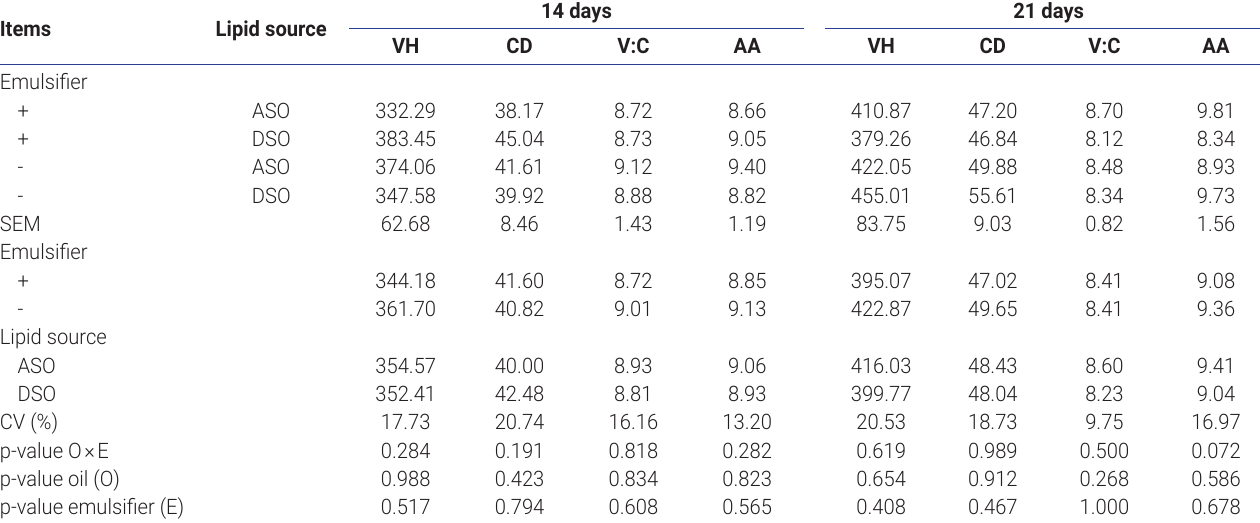
Table 8. Villus height, crypt depth, villus:crypt ratio, and area of absorption of jejunum of broilers fed diets containing different lipid sources, with or without emulsifier Items Lipid source